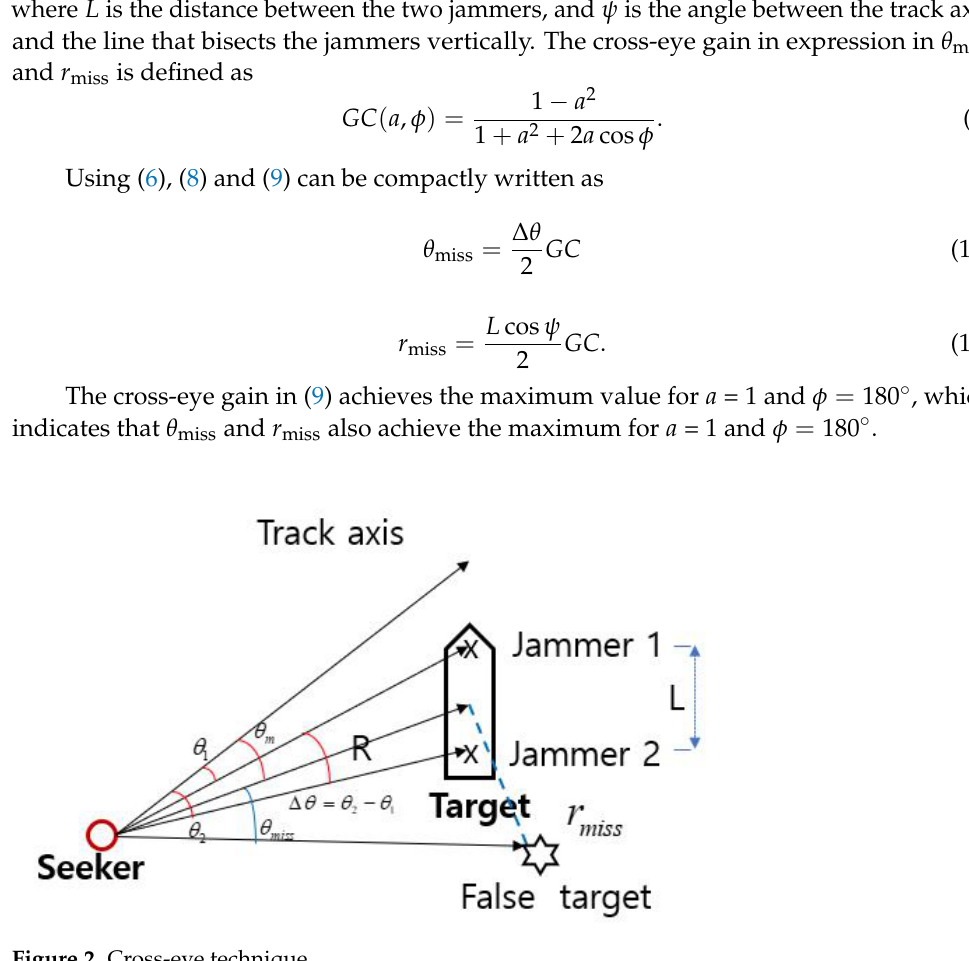
Figure 2. Cross-eye